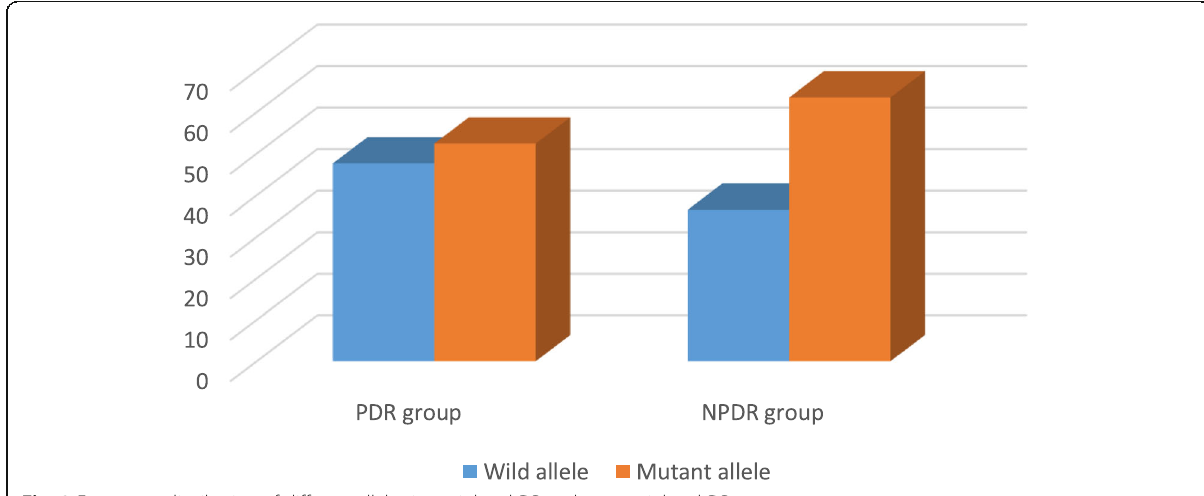
Fig. 3 Frequency distribution of different alleles in peripheral DR and non-peripheral DR